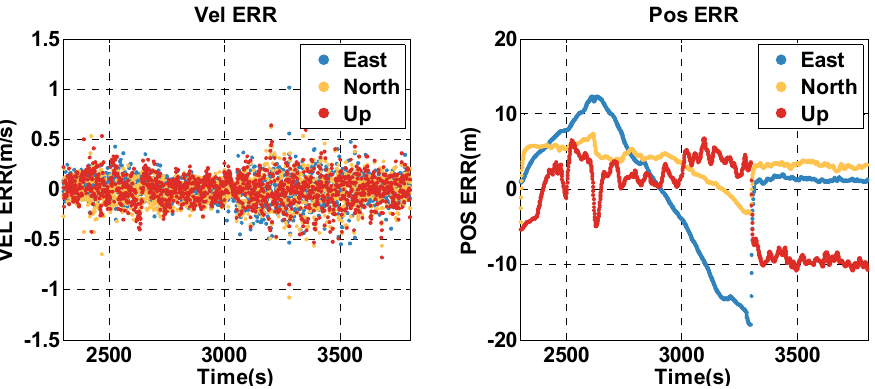
Figure 18. The position and velocity errors of the proposed MTF method in the satellite outage case.